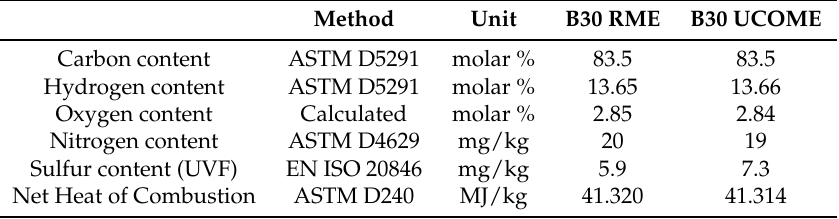
Table 2. The specifications of the B30 RME and B30 UCOME samples indicate only small differences between both fuels. The composition and heat of combustion were measured on B30 RME and B30 UCOME samples that were produced in the same way at the same refinery as the samples used in the presented tests.